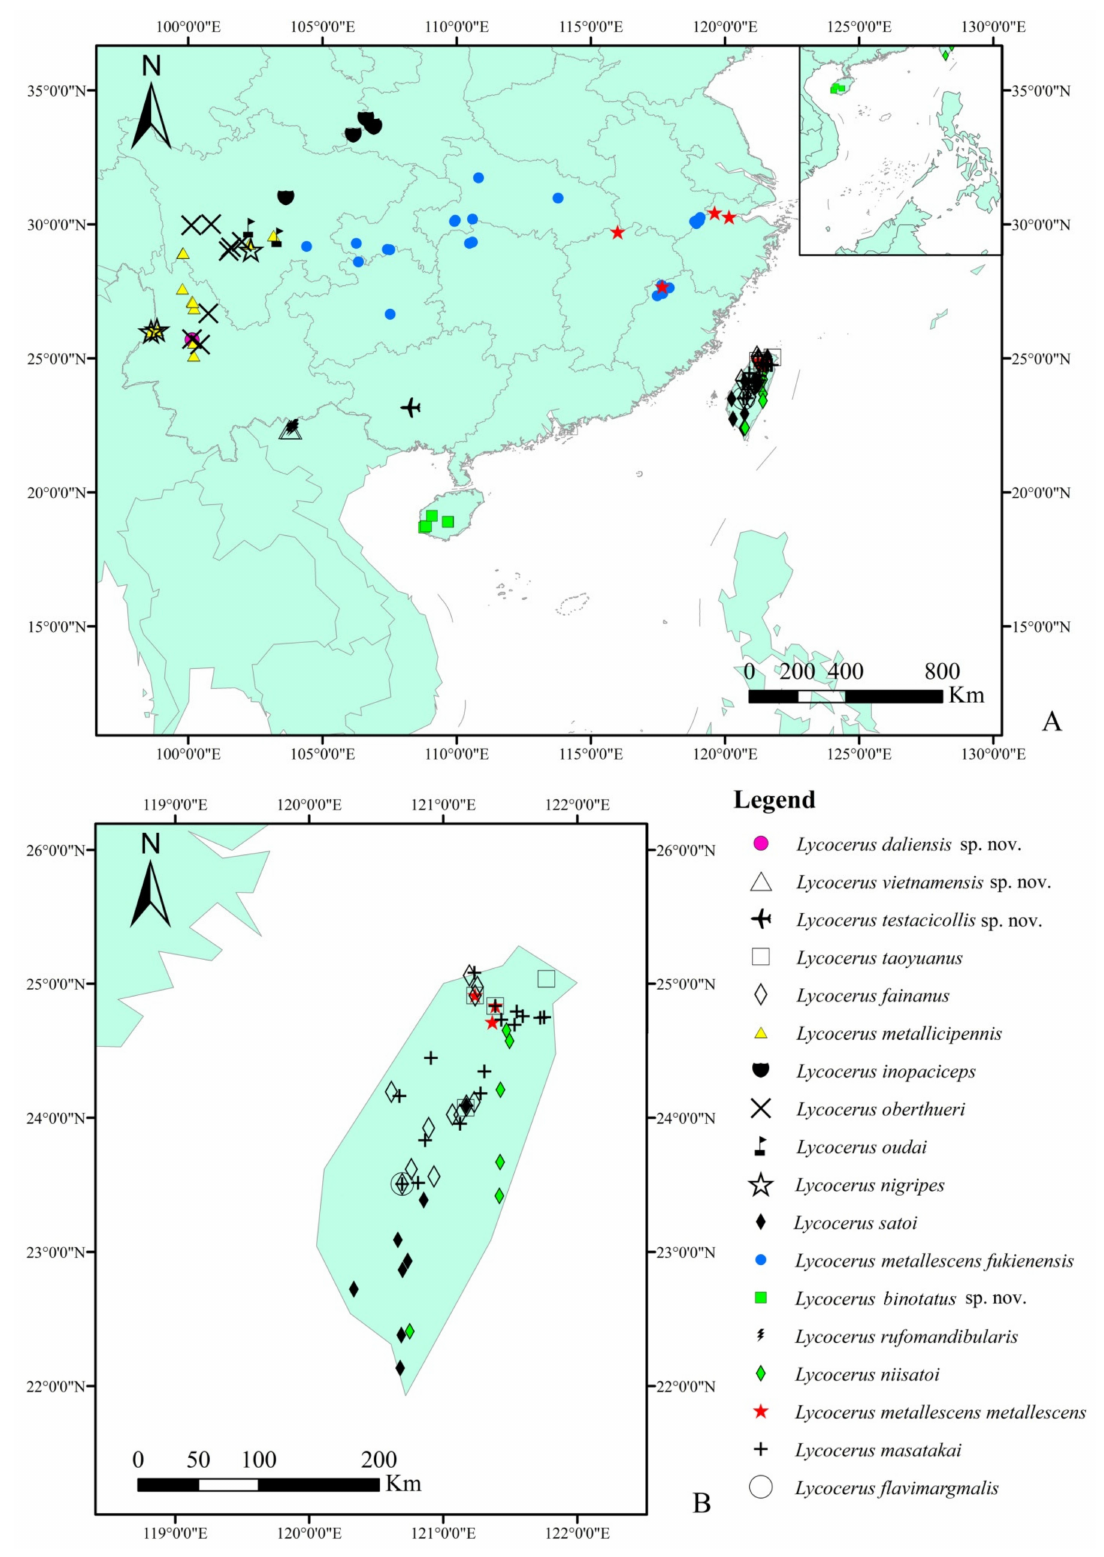
Figure 6. ( A ). Distribution map of Lycocerus fainanus species group in a general view; ( B ). Distribution map of the species from Taiwan in a close-up